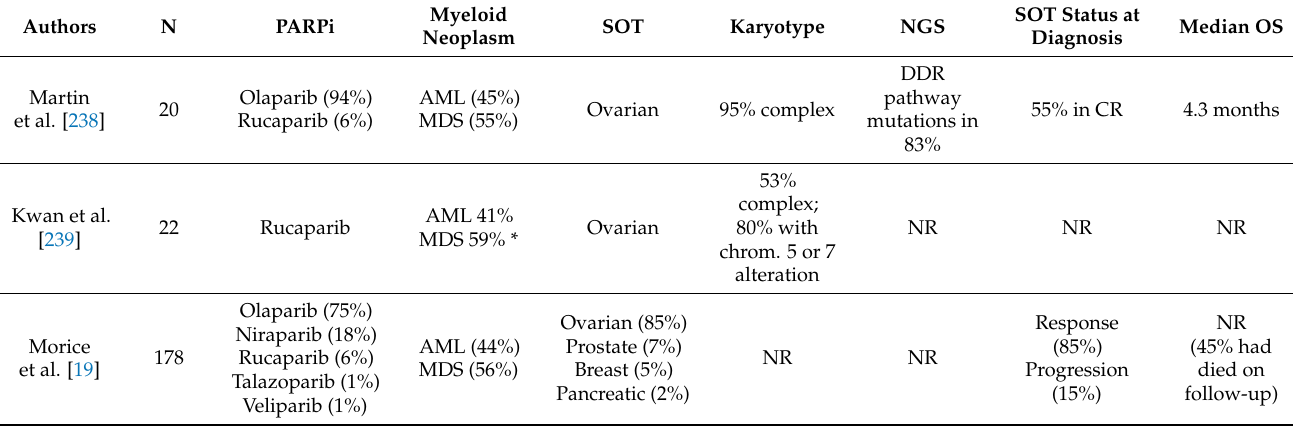
Table 5. Recent Studies of Therapy-Related Myeloid Neoplasms with PARP